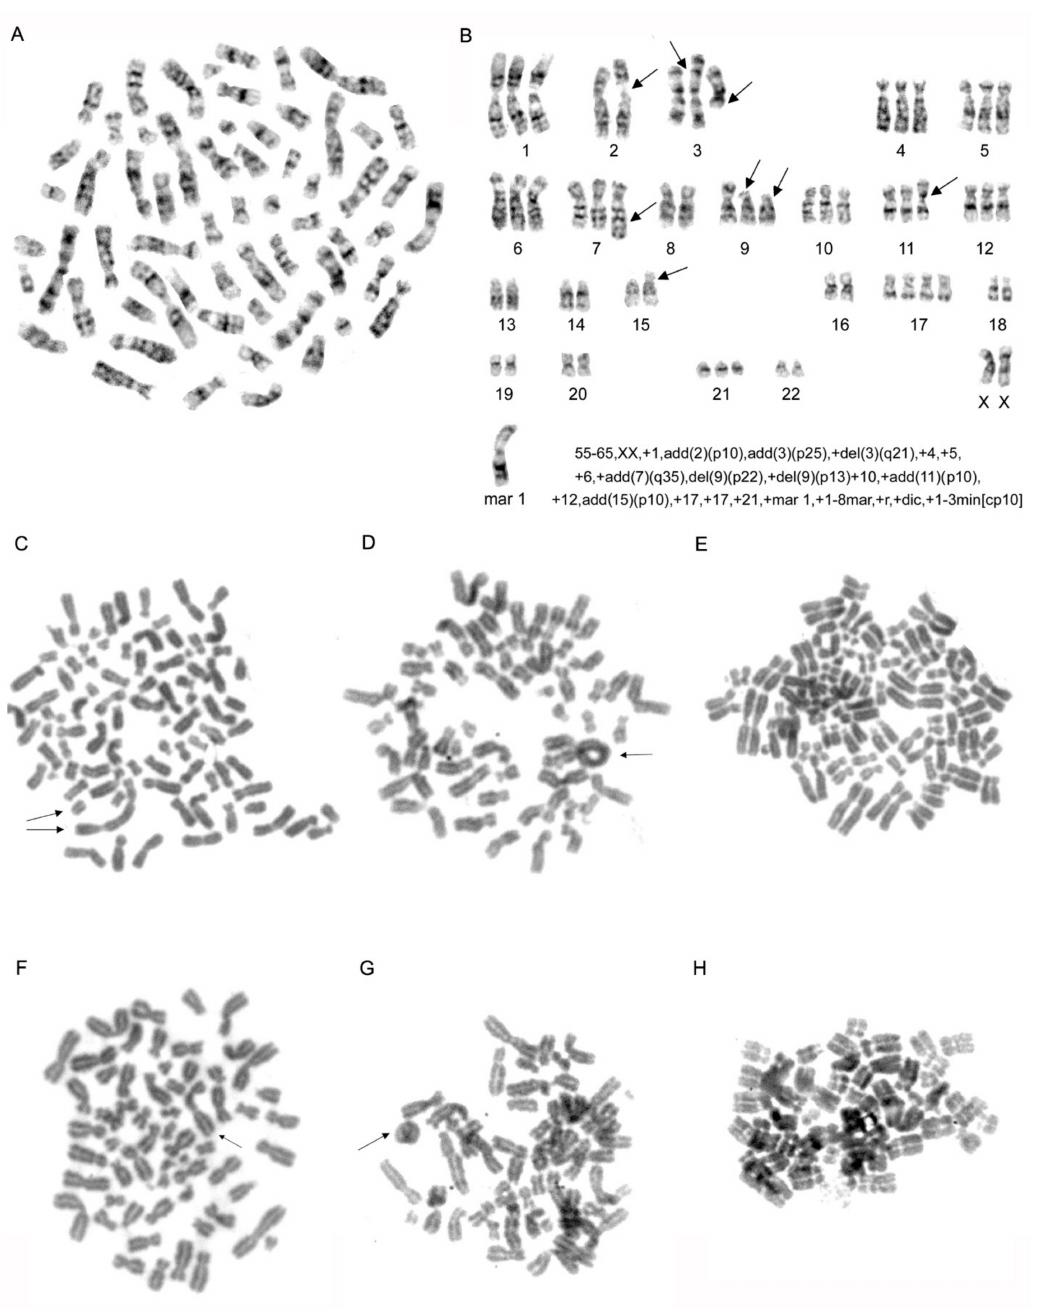
Figure 3. Karyotypic analysis of MDA-MB-231 breast cancer cells. ( A ). A representative G-banded karyotype of MDA- MB-231 cell line. ( B ). Composite G-banded karyotype of the near-triploid cell line MDA-MB-231, showing structural and numerical changes. Arrows point to main chromosomal alterations. Mar—Marker chromosome. ( C , D , F , G ). The representa- tive chromosome aberrations in β -actin ( C , D ) and γ -actin ( F , G ) -depleted MDA-MB-231 cells: dicentric chromosomes ( C , F ) and acentric fragment ( C ), ring chromosomes ( D , G ). Arrows point to aberrations. E, H. Endoreduplication in β -actin ( E ) and γ -actin ( H ) -depleted MDA-MB-231